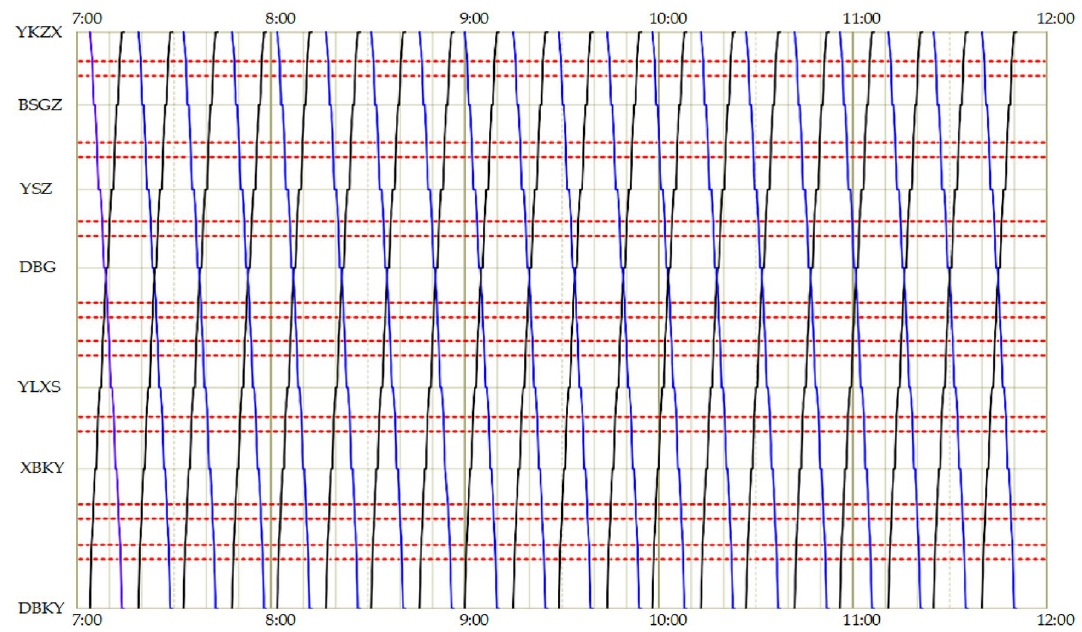
Figure 10. The tram timetable for adopting the active signal priority strategy